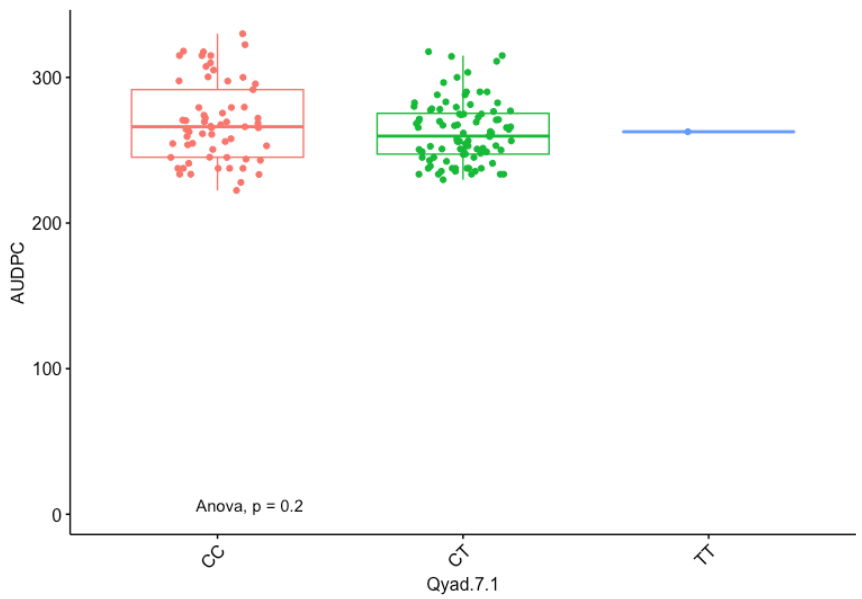
Figure 3. The boxplot showing the effect of the different alleles (variants) of Qyad-7-1 on the AUDPC values. The letters on the X-axis represent alleles (CC, CT, and TT).